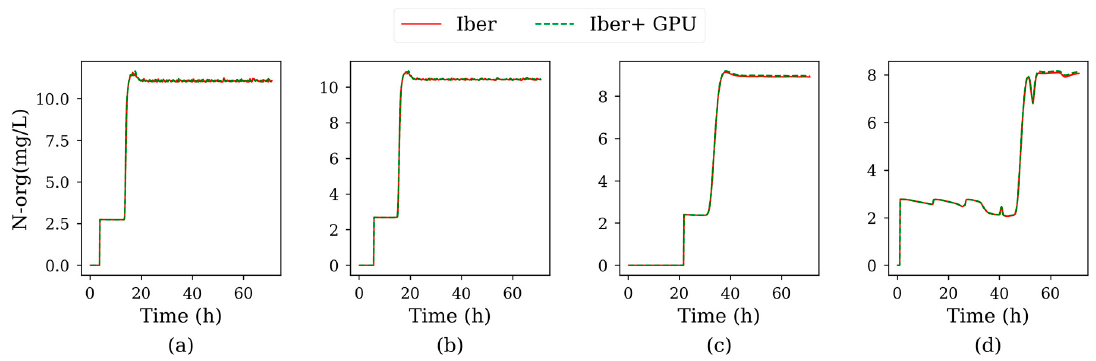
Figure A13. Time series of organic nitrogen for Test 4, sampled at control points P1 ( a ), P2 ( b ), P3 ( c ) and P4 ( d ).